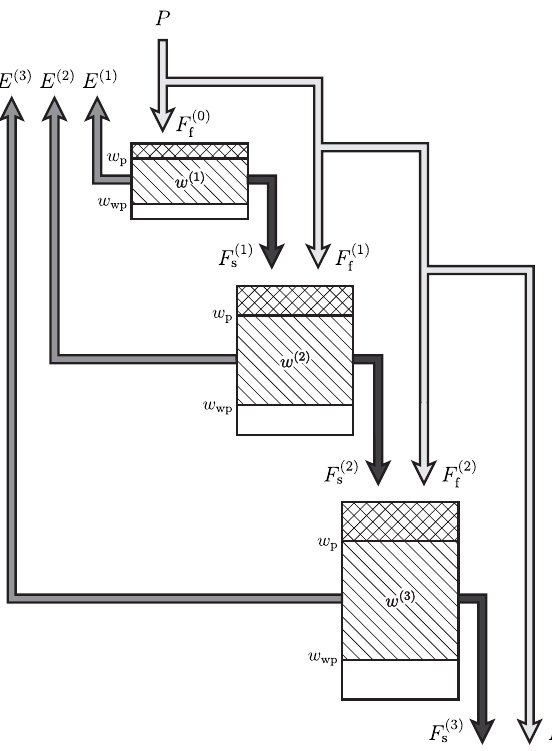
Figure 2. Schematic of the water-balance module implemented in GLEAM v3 for the fraction of tall vegetation. w (l) (m 3 m − 3 ) is the volumetric soil moisture content of layer l , F (l) s (mmday − 1 ) is the slow draining volume of water, F (l) volume of water, E (l) (mmday − 1 ) is the evaporative flux, P (mmday − 1 ) is the net precipitation, w wp (m 3 m − 3 ) is the wilting point, and w p (m 3 m − 3 ) is the